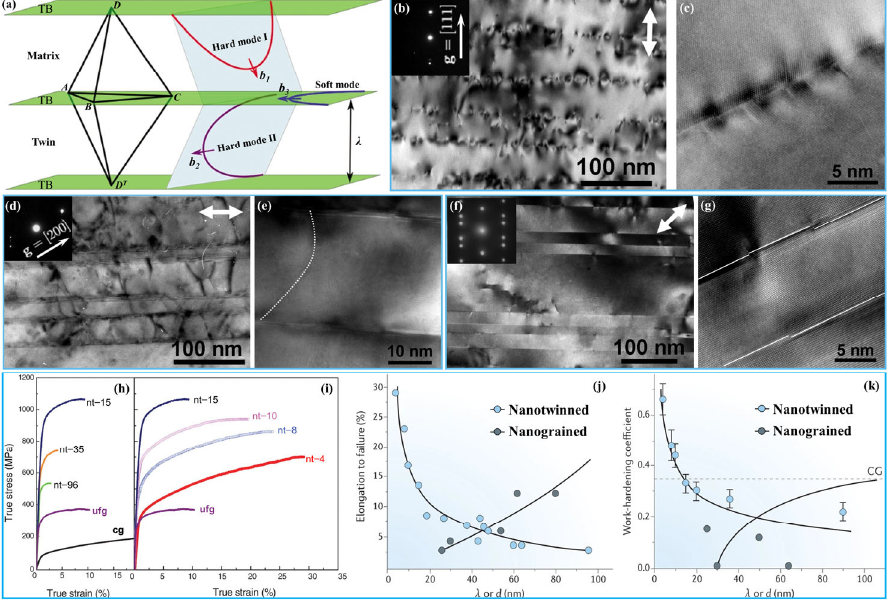
Figure 5. ( a ) Schematics showing the relative orientations between a double Thompson tetrahedra and twin lamellae, where b 1 , b 2 , and b 3 represent the slip direction of different modes [111]; TEM image and HRTEM images of NT Cu in different loading directions, where the arrow represents the loading direction [110]: ( b , c ) 90° compression with a strain of ~5%; ( d , e ) 0° compression with a strain of ~6% (the white dash lines represent threading dislocation); ( f , g ) 45° compression with a strain of ~7% (the white dash lines represent Shockley partial dislocation). The tensile true stress–strain curves of NT Cu with different λ (cg and ufg refer to the samples with coarse grain (10 μ m) and ultrafine grain (500 nm), respectively) varying ( h ) from 15 nm to 96 nm and ( i ) from 4 nm to 15 nm [60]; ( j ) the relationship between λ or d and elongation to failure, and ( k ) the relationship between λ or d and work ‐ hardening coefficient (the dashed line represent the coarse ‐ grained counterpart) [94].